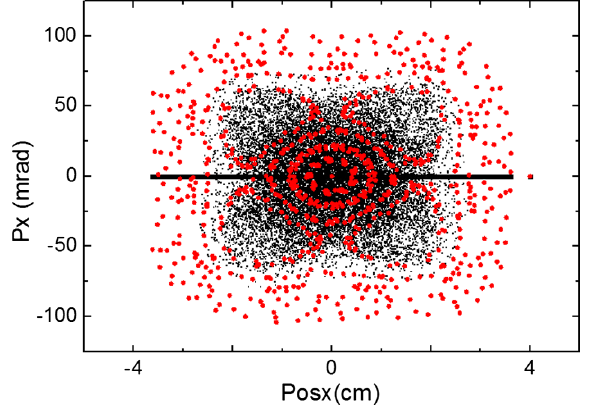
7. Plots of beam particle distribution in phase space at cell 100 (black dots) and Poincaré surface plot of ten test particles over 100 FD x axis are recorded at the end of each FD period over 100 periods to get the Poincaré surface plot. The red dots in Fig. 7 show the resonance structure of the system, which agrees well with the phase map, represented by the black dots, at cell 100.